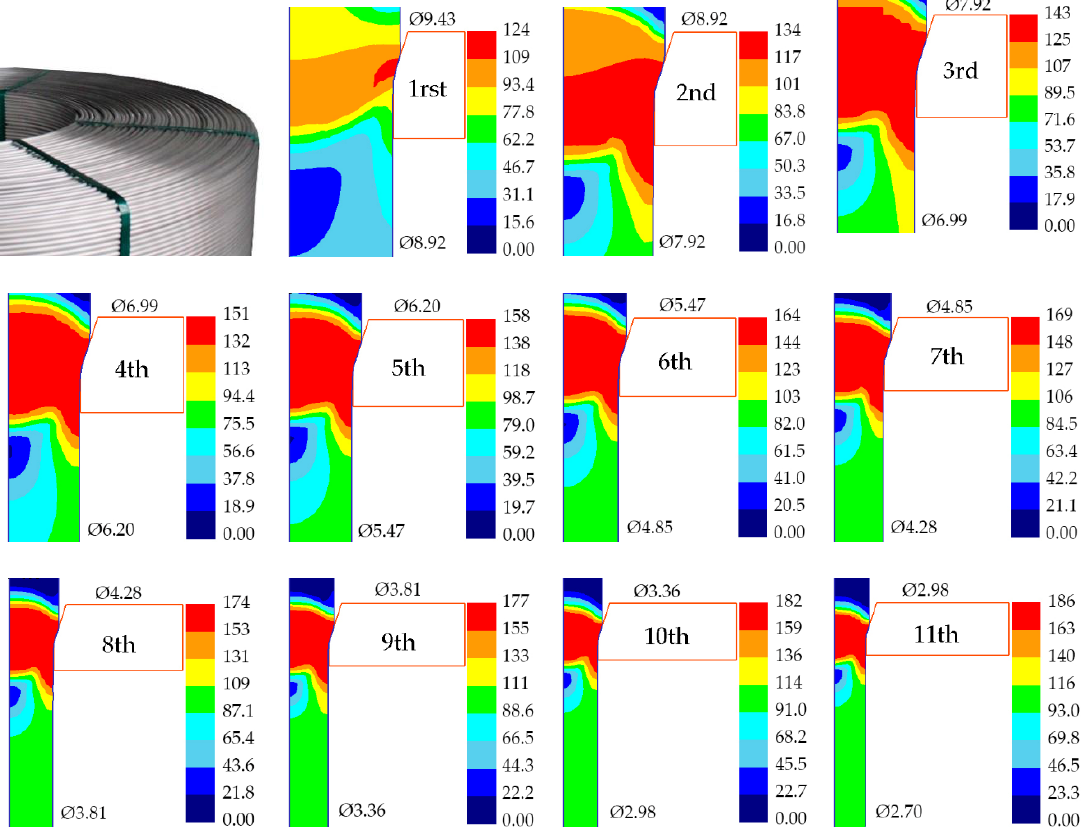
Figure 8. Effective stress distribution ( σ eff ) (MPa), in each of the stages of the stationary wiredrawing process. Equation (7) defines the drawing force ( F e ) as the product of the drawing stress ( σ draw ) and the area of the section of the drawn wire in each of the stages in the multi-stage wiredrawing process. Table 5 presents the results obtained for the drawing force and the main stresses involved in the wiredrawing process and concerning to the complete wiredrawing sequence.